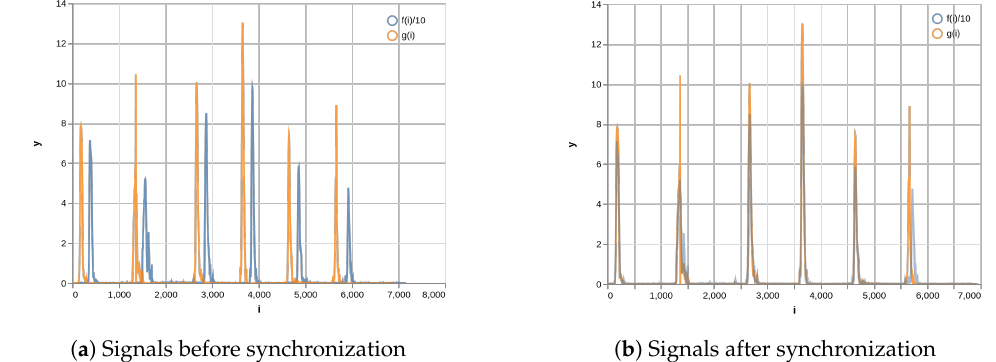
Figure 15. Signals before and after synchronization. The blue line means the function, f ( i ) , of the position changes of the pattern board monitored by the motion-tracking sensor; the red line means the function, g ( i ) , of the position changes of the pattern board detected by the canvas